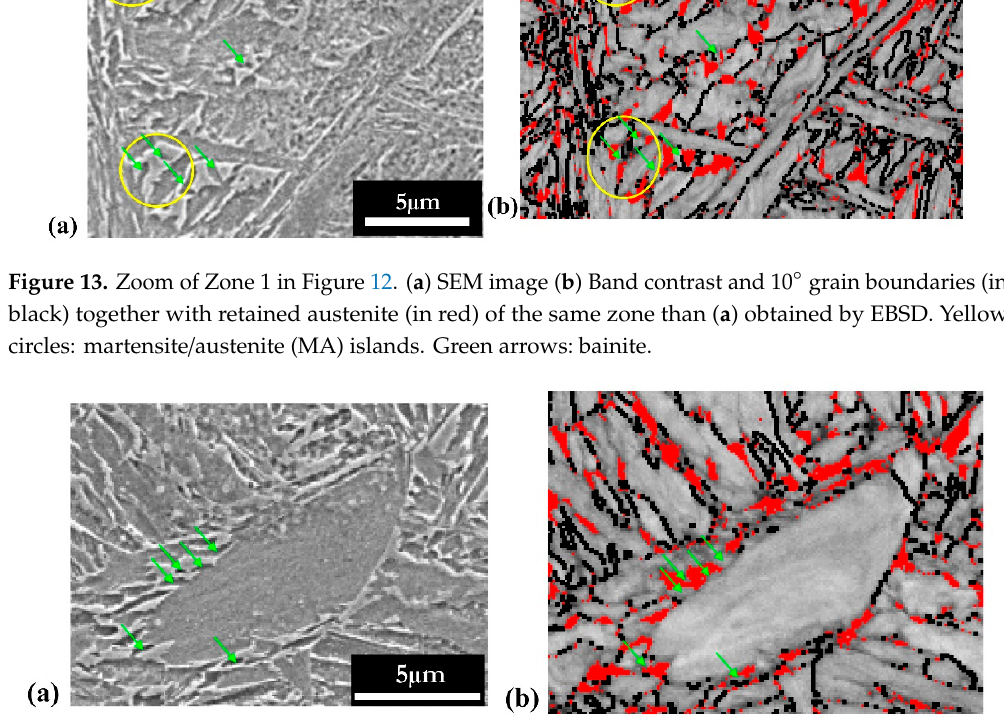
Figure 14. Large martensite lath with surrounding bainite laths (green arrows). ( a ) SEM image ( b ) Band contrast and 10° grain boundaries (in black) together with retained austenite (in red) of the same zone than a) obtained by EBSD.